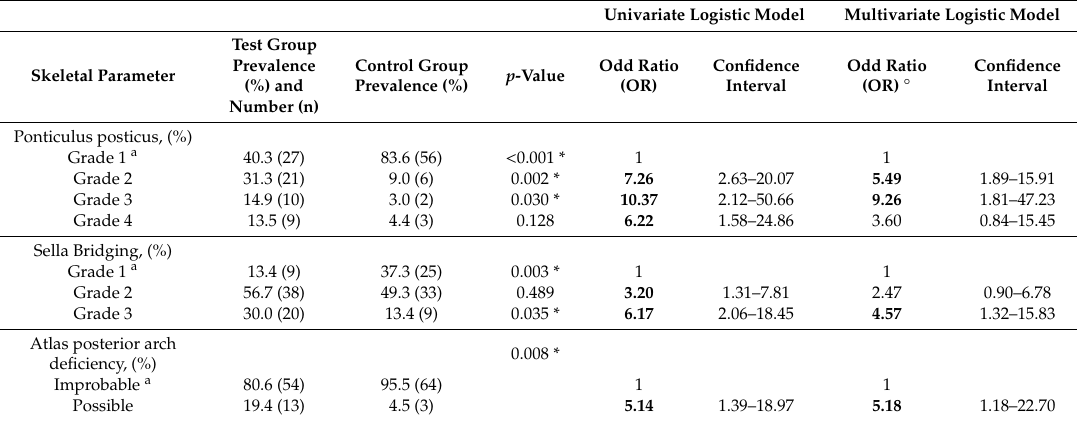
Table 3. Descriptive statistics and results of Univariate and Multivariate logistic models for the following skeletal parameters: PP, sella turcica bridging (SB) and atlas posterior arch deficiency (APAD).